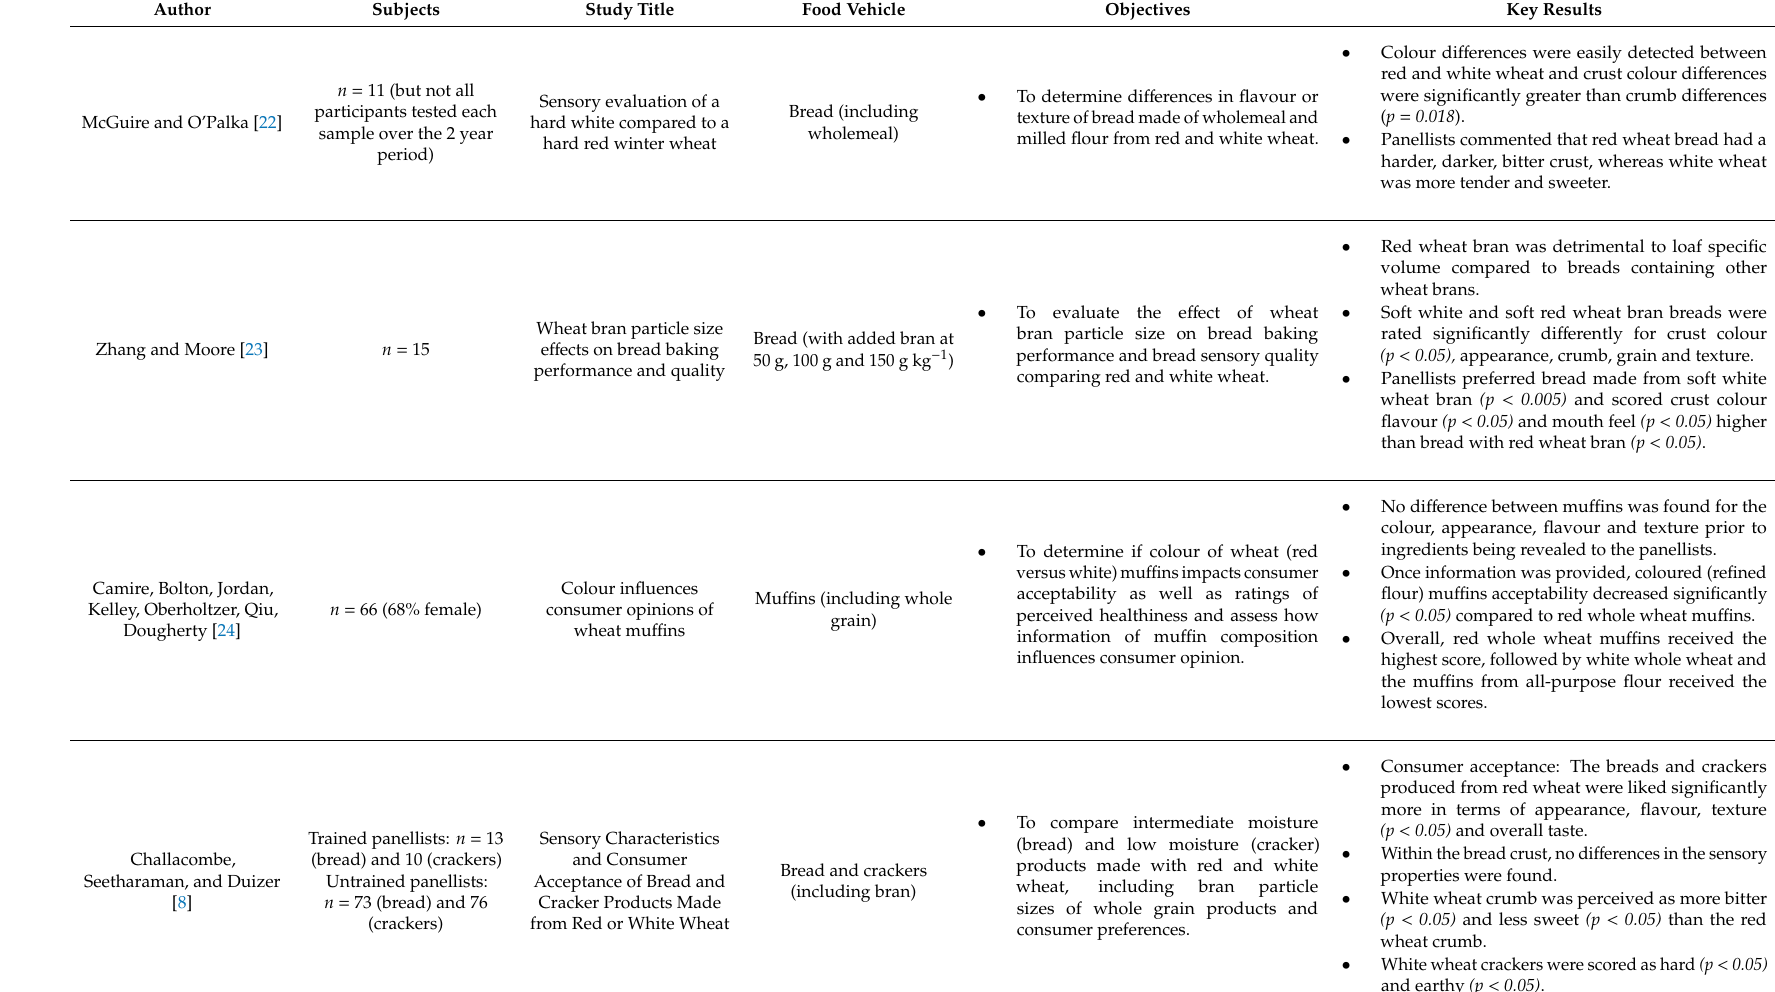
Table 1. Red and white wheat sensory studies published